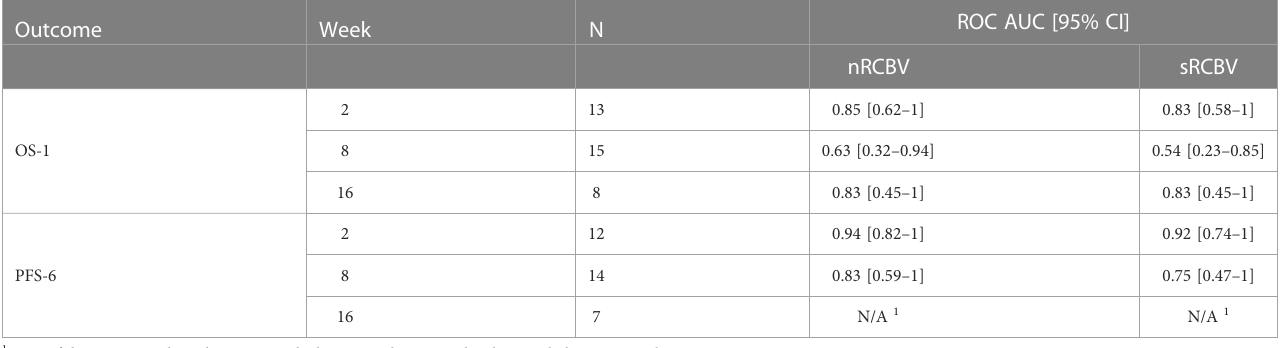
TABLE 3 Empirical ROC AUC for percent change in nRCBV and sRCBV by time point and patient outcome (OS-1 and PFS-6) among the cohort of 2D-T1 non-progressors.